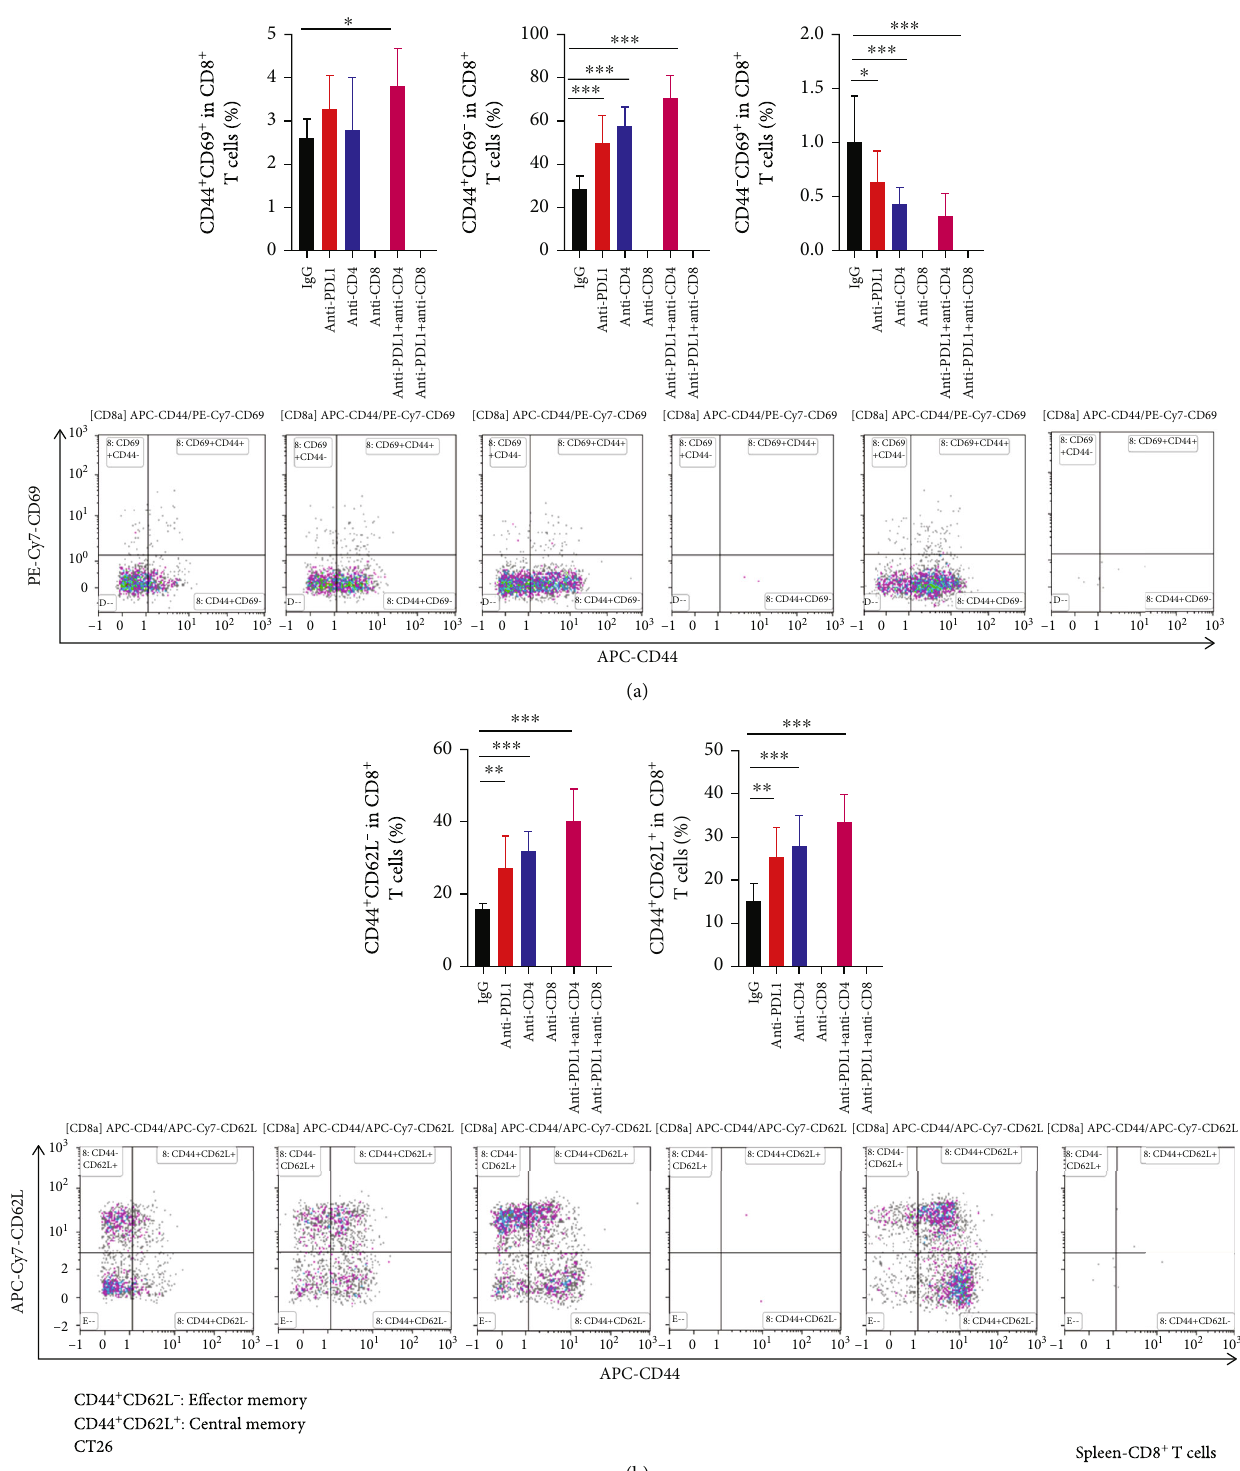
Figure 4: PD-L1 blockade and CD4 + T cell depletion additively promoted splenic CD8 + T cell activation. CT26 tumor-bearing mice were prepared and treated as described in Figure 1. On day 12 post anti-PD-L1 treatments, spleens were harvested for fl ow cytometric analysis. (a) The percentages of CD44 + CD69 + , CD44 + CD69 - , and CD44 - CD69 + cells in the CD8 + T cell population as well as representative fl ow fi gures were shown. (b) The percentages of CD44 + CD62L - and CD44 + CD62L + cells in the CD8 + T cell population as well as representative fl ow fi gures were shown. Signi fi cant di ff erences were determined by one-way ANOVA ( n = 7 − 8 mice per group). Data were shown as means ± SD . ∗ P < 0 : 05 , ∗∗ P < 0 : 01 , ∗∗∗ P < 0 : 001